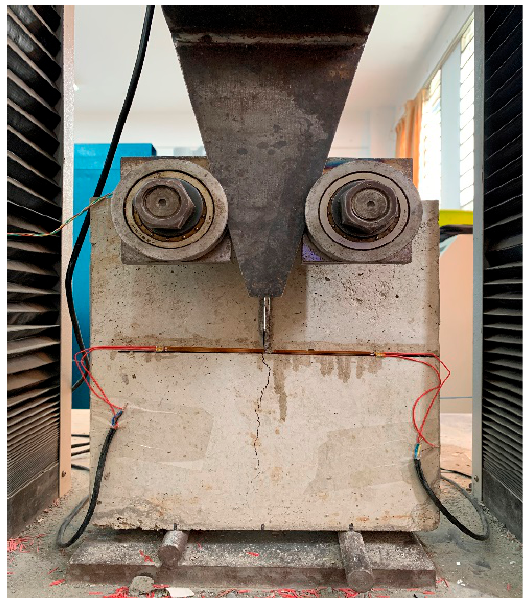
Figure 1. TY ‐ 8000 testing machine and test loading process